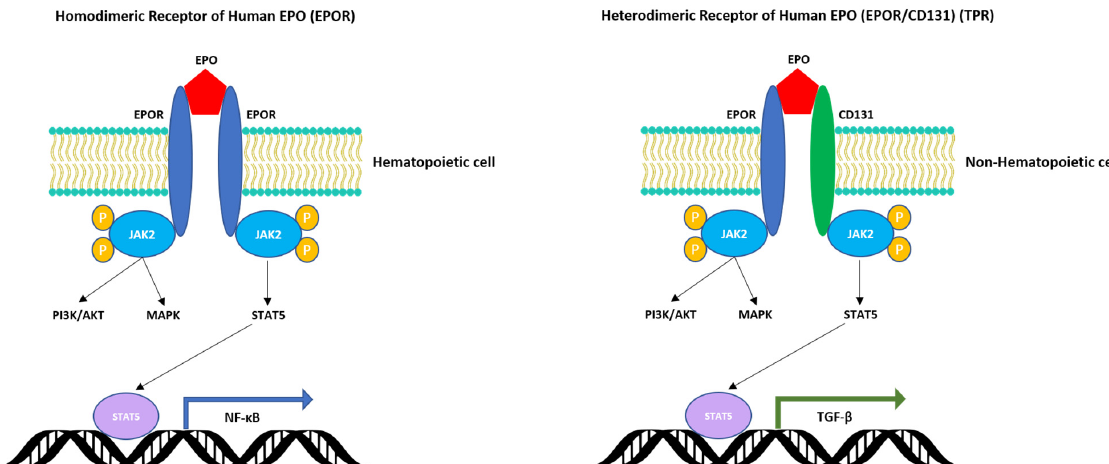
Figure 2. Illustration of the interactions of human EPO with its homodimeric (EPO-R) and heterodimeric receptor (EPO- R/CD131, or tissue protection receptor (TPR)). These receptors are activated in hematopoietic (erythroid progenitors) and non-hematopoietic cells (brain, heart, skeletal muscle cells, others), respectively. Activation of the homodimeric EPO-R receptor leads to cell signaling in BM proerythroid cells, while activation of the heterodimeric EPO-R/CD131 leads to the increase of cell renewal, survival and protection of non-hematopoietic cells. For both cases of EPO-R signaling, the activation pathways shown above are mediated by the phosphorylated JAK2 kinases, which then interact with the intracellular regions of the receptor and activate the PI3K/AKT, MAPK and STAT5 molecules by a phosphorylation cascade. The transcription regulator STAT5 interacts with consensus DNA sequences that facilitate the activation of the NF-kB transcription factor [5,6,57]. In the case of the activation of the EPO-R/CD131 receptor by EPO in non-hematopoietic tissues, the induced cell signaling promotes the phosphorylation of similar molecules, the activation of STAT5 and eventually the expression of TGF- β [28].